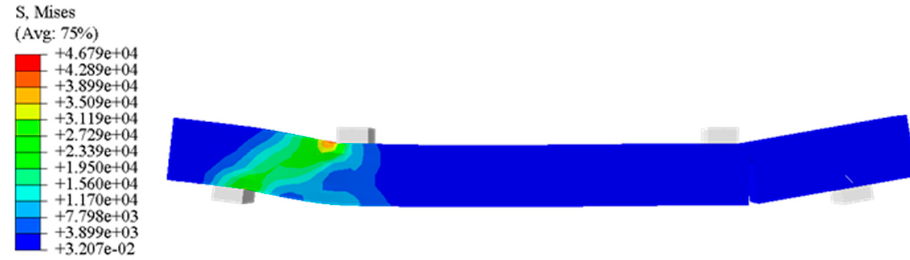
Figure 4. Stress nephogram for the concrete beam (N/mm 2 ).